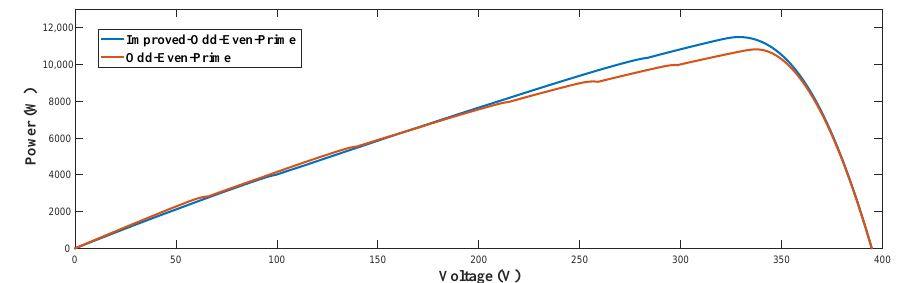
Figure 7. Voltage–power characteristics of 9 × 9 PV array for case-3 (Bottom-Left)